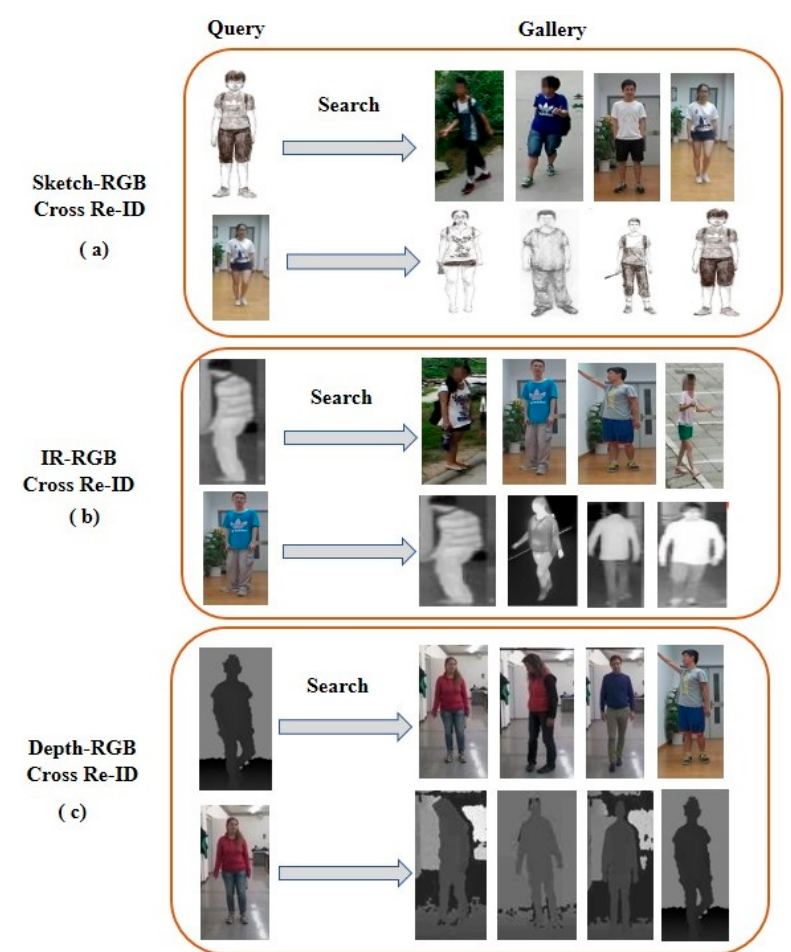
Figure 10. Illustration of cross-modal person Re-ID. ( a ) Sketch–RGB cross-modal Re-ID uses sketch as a query and RGB as a gallery or vice versa. ( b ) IR–RGB cross-modal Re-ID uses IR as a query and RGB as a gallery or vice versa. ( c ) Depth–RGB cross-modal Re-ID uses depth as a query and RGB as a gallery or vice versa.